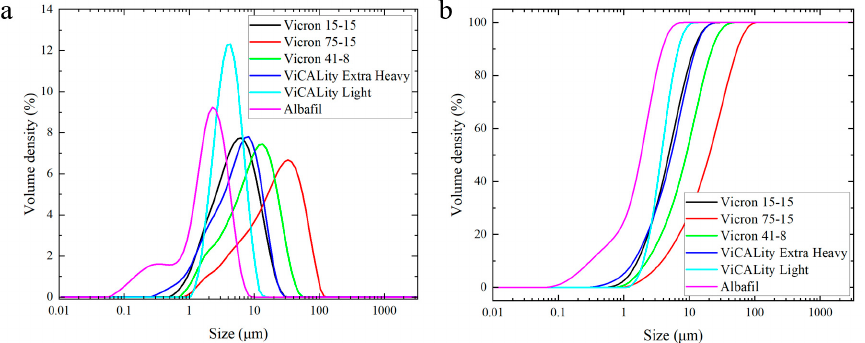
Figure 2. Particle size analysis of CaCO 3 as-received powders in IPA suspension. Data are presented as volume density as a function of particle size in normalized ( a ) and cumulative normalized ( b ) volume.